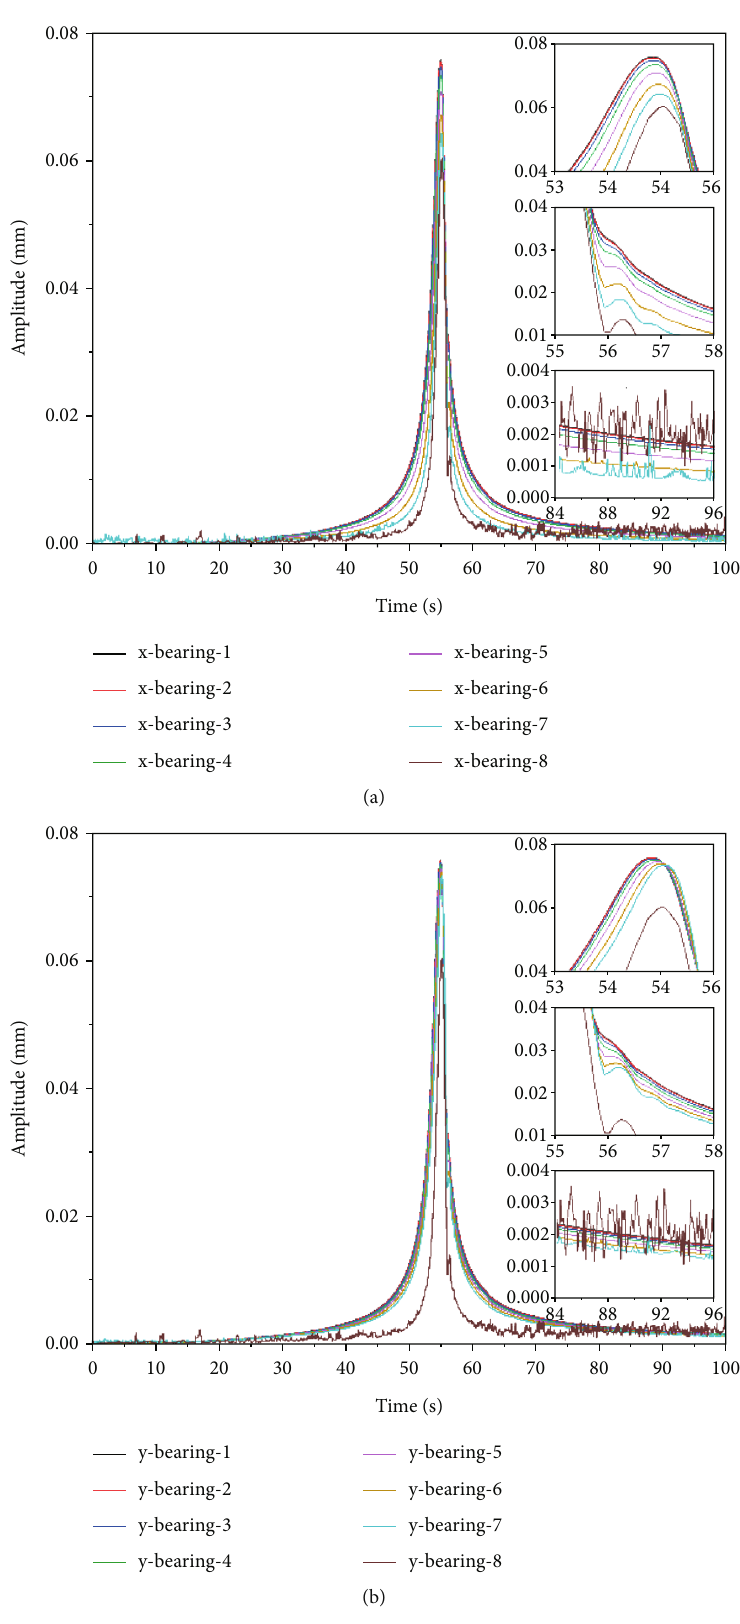
Figure 20: Variations of the node displacements at the rear bearing during run-up process. (a) Response in the x -axis direction. (b) Response in the y -axis